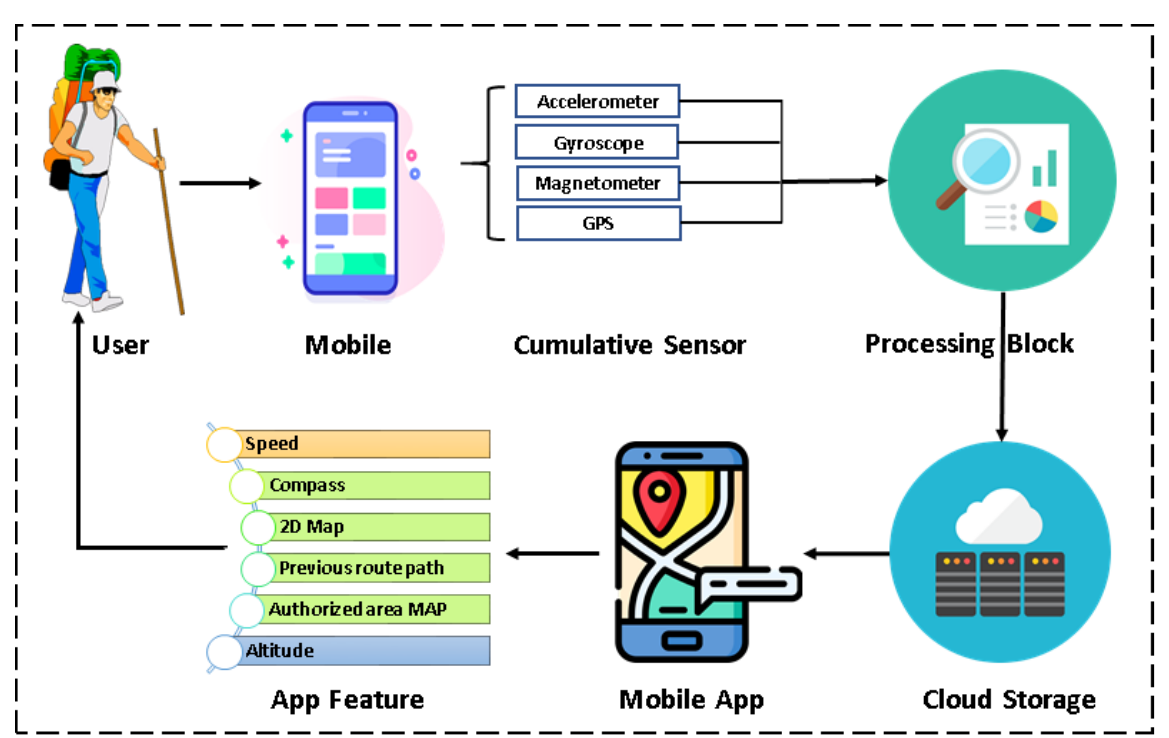
Figure 1. System architecture showing the detailed activity of the proposed